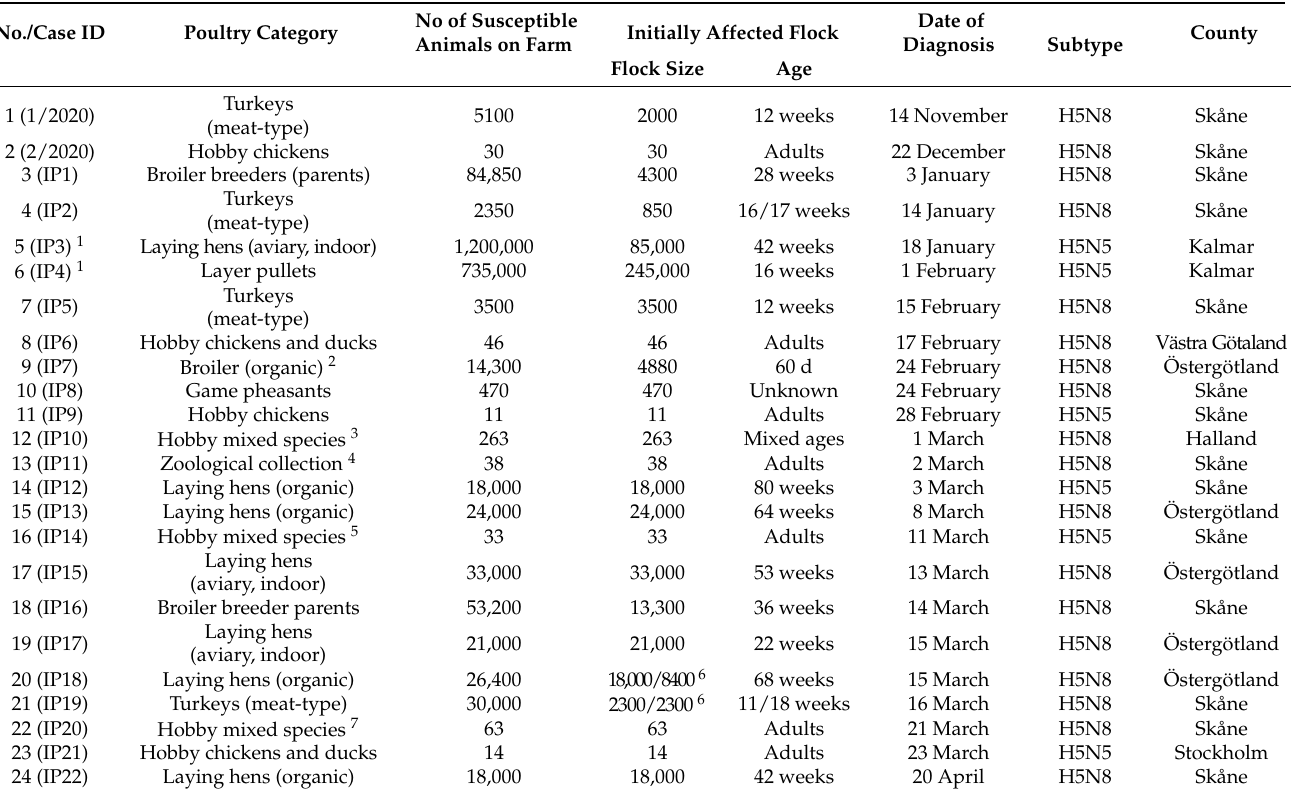
Table 3. HPAI H5Nx, clade 2.3.4.4.b outbreaks in poultry and captive birds during the 2020–2021 season in Sweden. Flock size and age refers to the first affected flock/flocks on outbreak